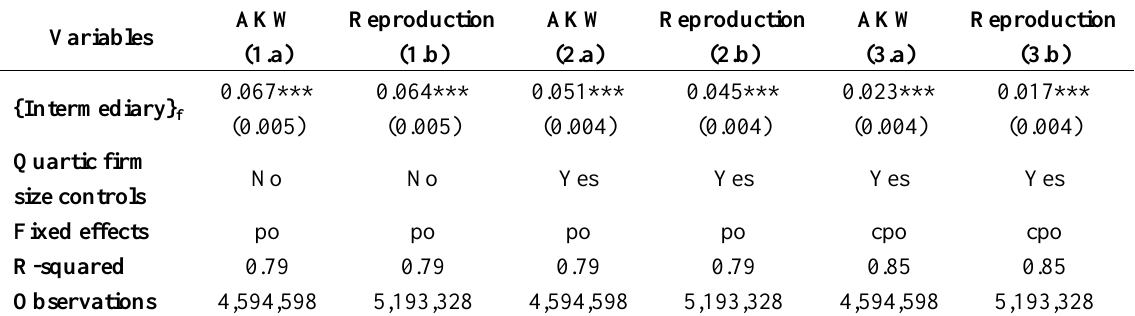
Table 2: Reproduction of AKW’s results: Prediction